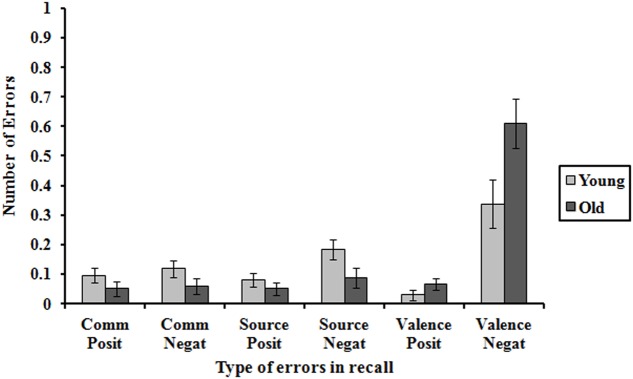
Mean number of commission errors, source errors, and change of valence errors in the recall of positive and negative future events in young and older adults. Error bars represent standard errors.